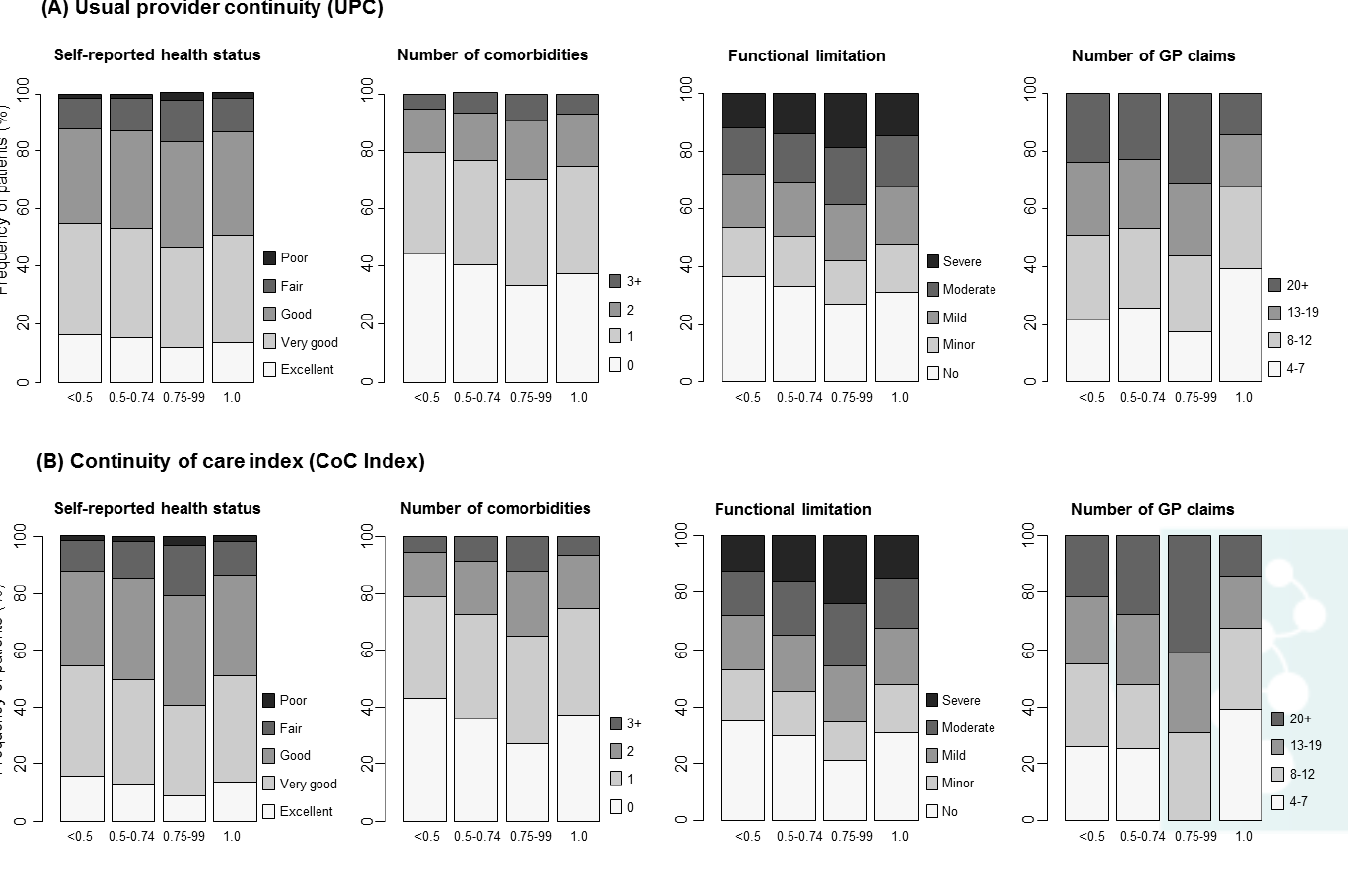
Figure 2: Distribution of health characteristics and number of GP claims by category of (A) usual provider continuity (UPC), and (B) Bice-Boxerman Continuity of Care Index (CoC